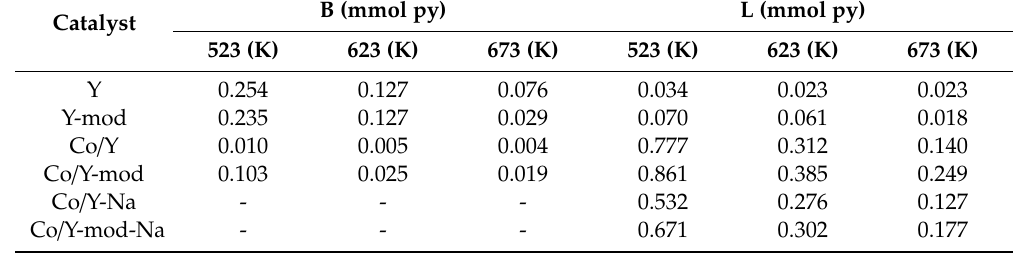
Table 3. Acidity of the catalysts and supports studied in this work.